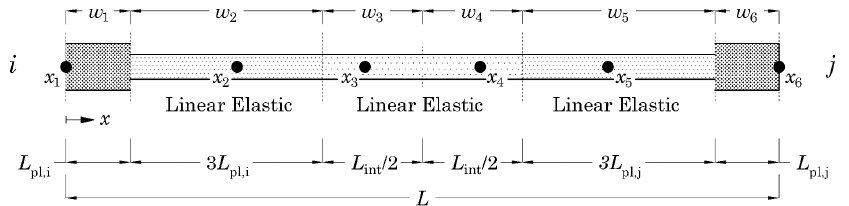
Figure 5. ForceBeamColumn element with HingeRadau (Modified Two-Point Gauss-Radau) quadra- ture rule.